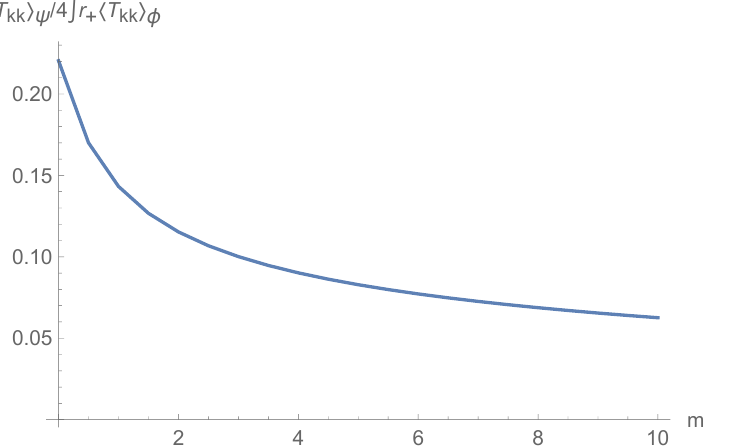
R (cid:25)= 2 Figure 6 . Plot of the ratio of the quantity R 1 d(cid:30)dUr + h T kk i at extremality for one four- 0 (cid:0) (cid:25)= 2 dimensional complex spinor (cid:12)eld and four four-dimensional real scalar (cid:12)elds of the same four- dimensional mass m . ‘=R S = 10 with a cuto(cid:11) (cid:15) = 0 : 01. The sum over Kaluza-Klein modes 1 was performed to N = 1000 and the sum over BTZ images was performed to n = 5. The spinor contribution to the integrated stress-energy tensor is always signi(cid:12)cantly less than that of the scalars with an equivalent number of degrees of